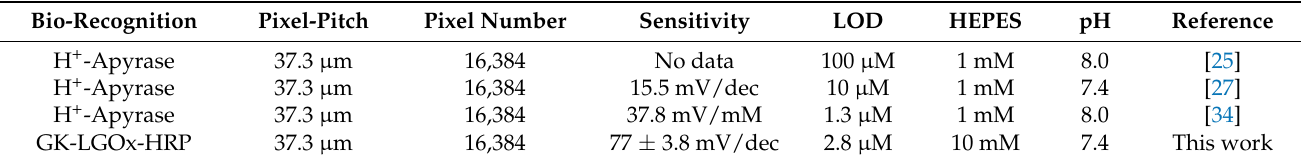
Figure 11. The detection limit of the ATP image sensor plotted against the various concentrations of HEPES at pH 7.4. Table 1. Comparison of sensing performance of the image sensor for ATP detection and its experi- ment